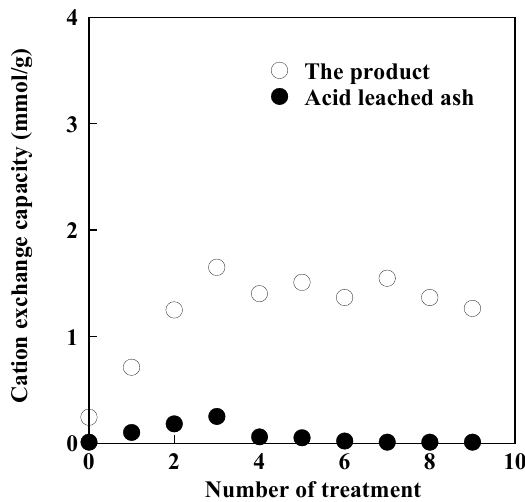
Figure 6. Cation-exchange capacities (CECs) of leached ashes and products synthesized from ashes leached with 1 M HCl solution for various numbers of leaching treatments.